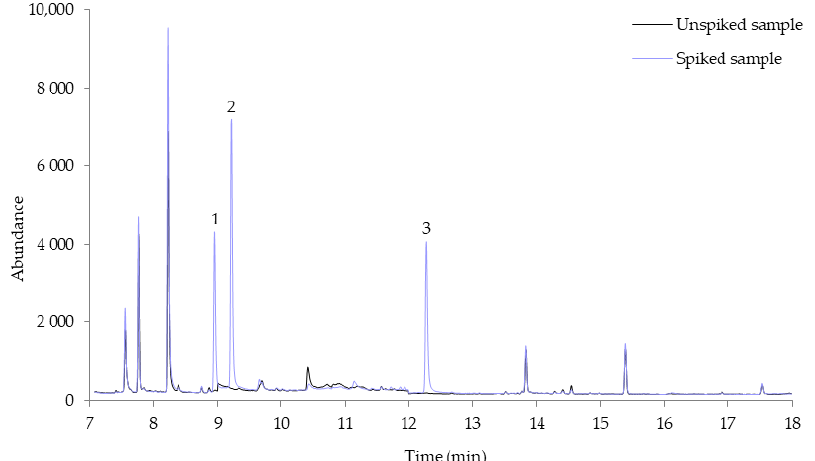
Figure 2. Total ion chromatograms from assays performed on spiked (500.0 µg L − 1 ) and unspiked oral fluid samples obtained by BAµE(Strata-X)-µLD/GC-MS(SIM) under optimized experimental conditions. 1: α - PVP; 2: α -PVT; and 3: MDPV.